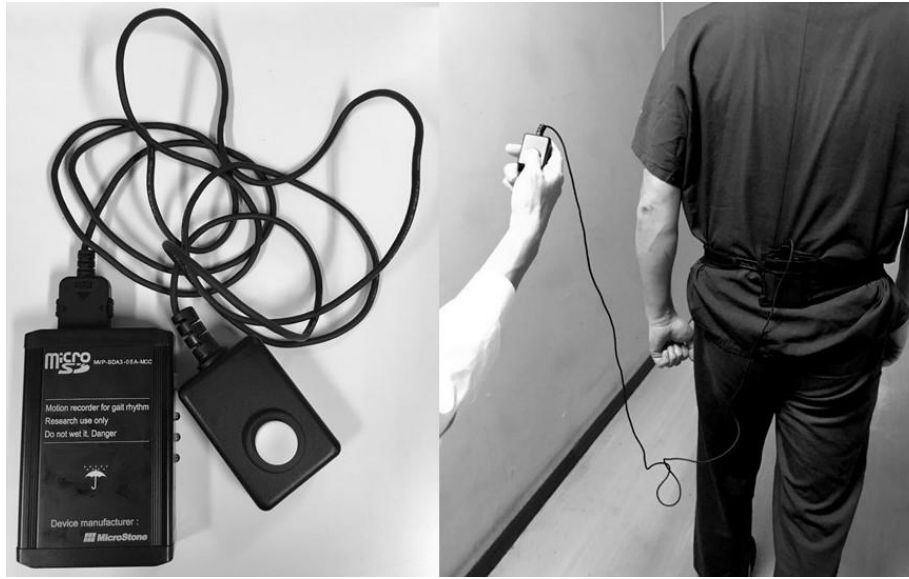
Figure 1. Tri-axial accelerometer (MG-M1110) with a switch cable for marking points of a 10-m walking interval for the dataset ( left ) and the accelerometer fixed at the L3 level by a nylon belt in a subject ( right ).